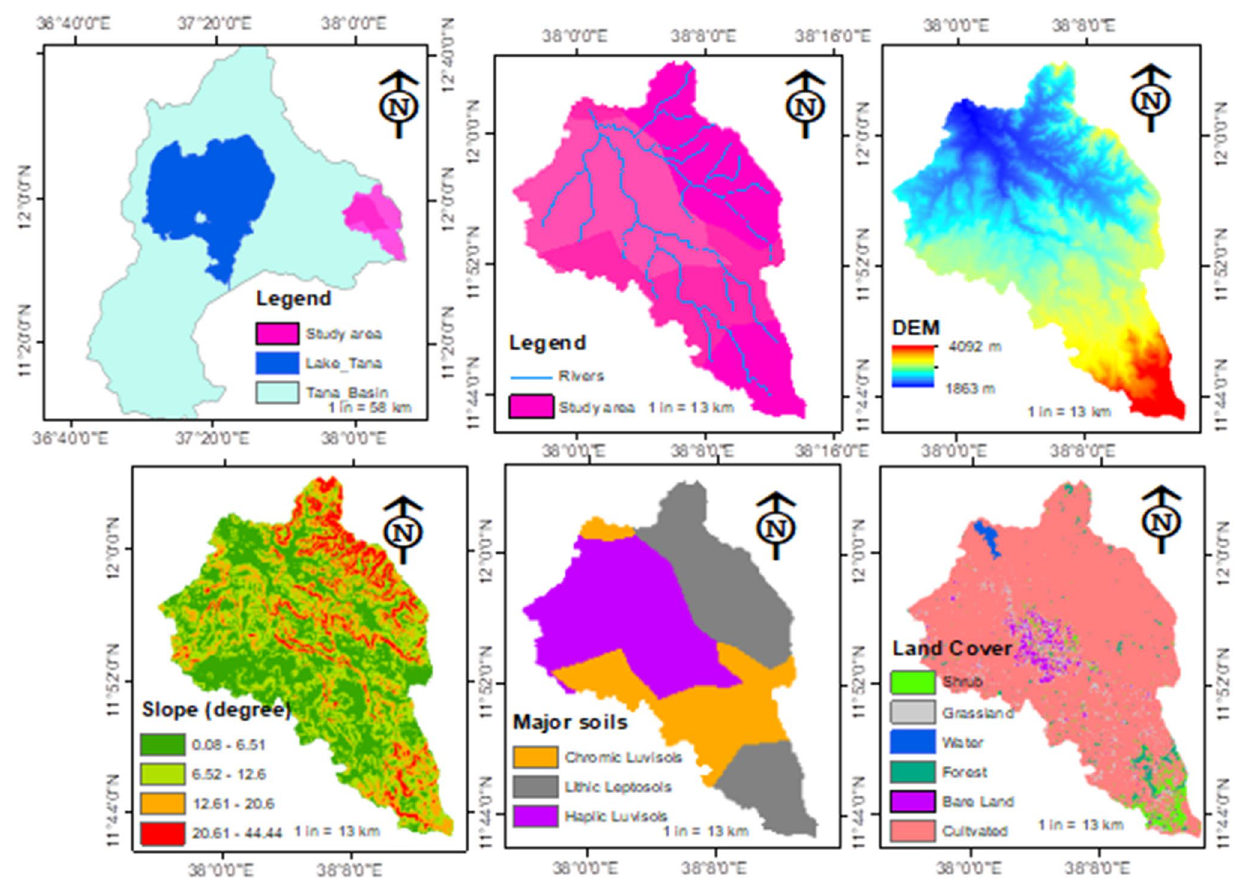
Fig. 1 Locations of Ribb